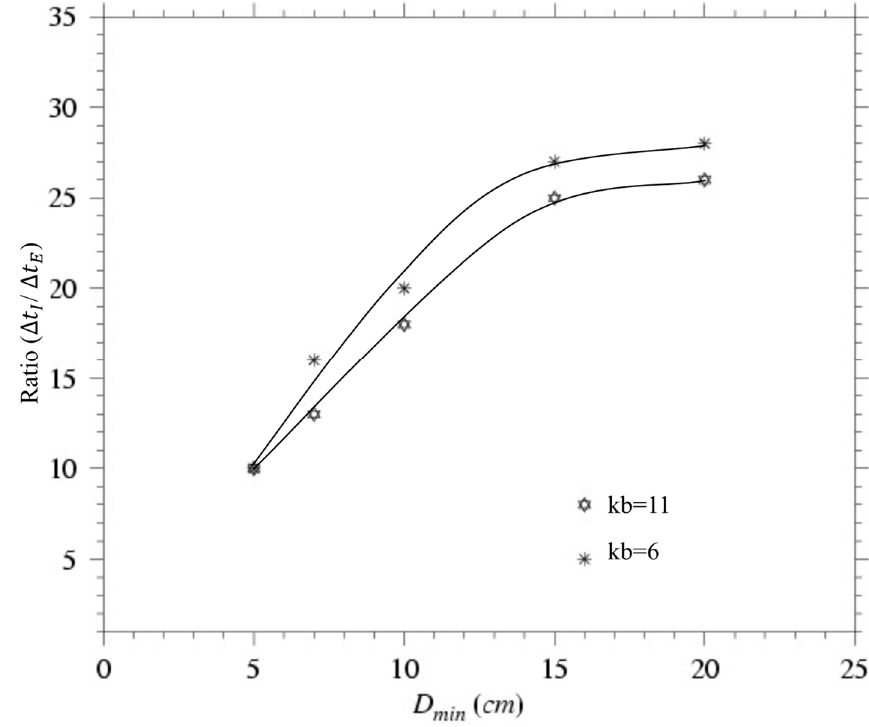
Figure 9. The model-derived relationship of ∆ t I / ∆ t E with D min for the two cases with kb = 6 and 8, respectively. In these two cases, ∆ t E = 4.14 s, α = 4.0 × 10 − 4 , and ζ o = 1.5 m.